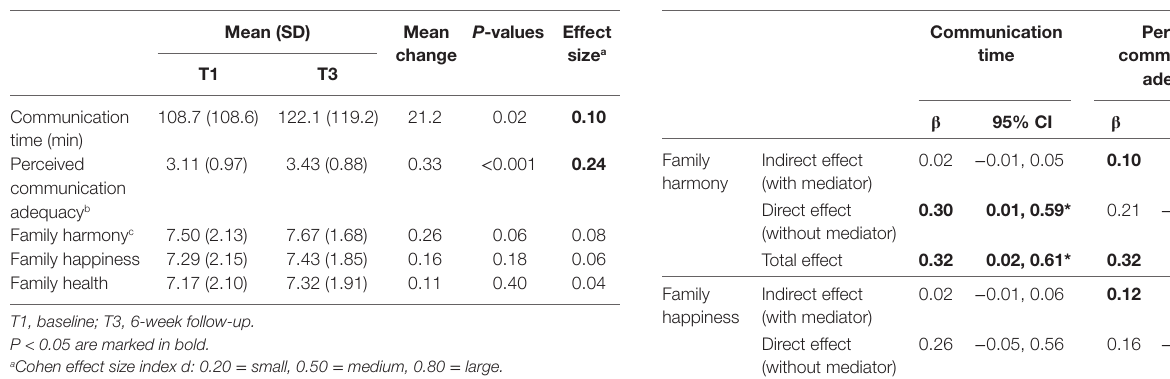
TaBle 4 | Adjusted a indirect, direct, and total effect of intervention on family 3Hs mediated by family communication.